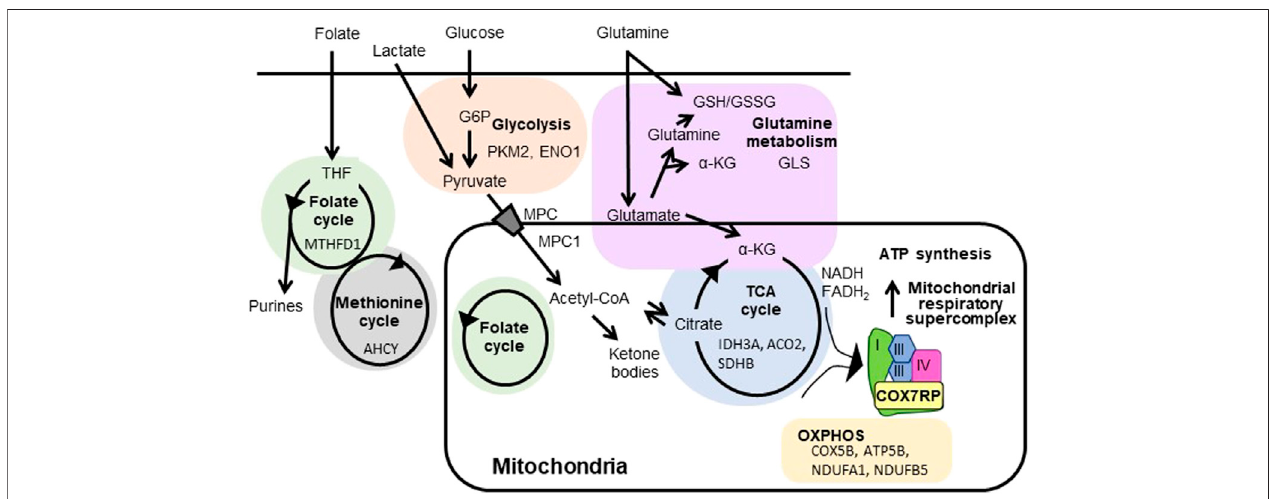
FIGURE 1 | Regulation of mitochondrial respiratory supercomplex assembly by COX7RP and metabolism by ERRs. COX7RP functions as a promoting factor for mitochondrial respiratory supercomplex assembly, leading toef fi cient ATP production. Metabolic pathways reported to be promoted by ERRs inbreast cancer cells are alsoindicatedwiththerepresentativetargetgenes.COX7RP,cytochrome c oxidasesubunit7arelatedpolypeptide; α -KG, α -ketoglutarate;G6P,glucose-6-phosphate; GSH, the reduced glutathione; GSSG, glutathione disul fi de; MPC, mitochondrial pyruvate carrier protein; THF, tetrahydrofolate; PKM2, pyruvate kinase; ENO1, enolase 1; MTHFD1, methylenetetrahydrofolate dehydrogenase, cyclohydrolase and formyltetrahydrofolate synthetase 1; AHCY, adenosylhomocysteinase; MPC1, mitochondrial pyruvate carrier 1; NDUFA1, ubiquinone oxidoreductase subunit A1; NDUFB5, ubiquinone oxidoreductase subunit B5; COX5B, cytochrome c oxidase subunit 5B; ATP5B, ATP synthase, H+ transporting mitochondrial F1 complex, beta subunit; IDH3A, isocitrate dehydrogenase (NAD(+)) three catalytic subunit alpha; ACO2, aconitase 2; SDHB, succinate dehydrogenase complex fl avoprotein subunit B; GLS,